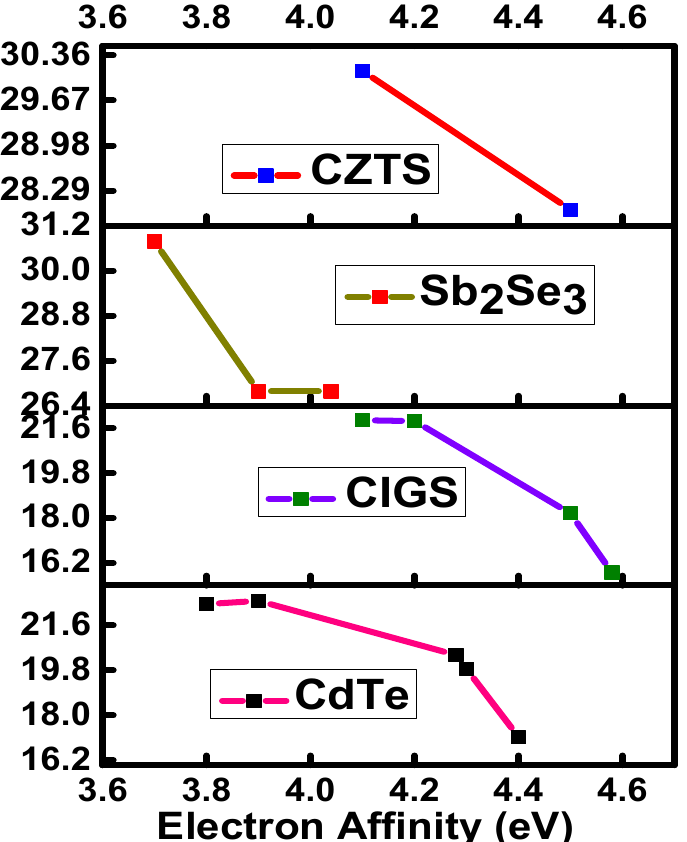
Figure 5. Effect of different absorber layer’s electron affinity on the efficiency of solar device.